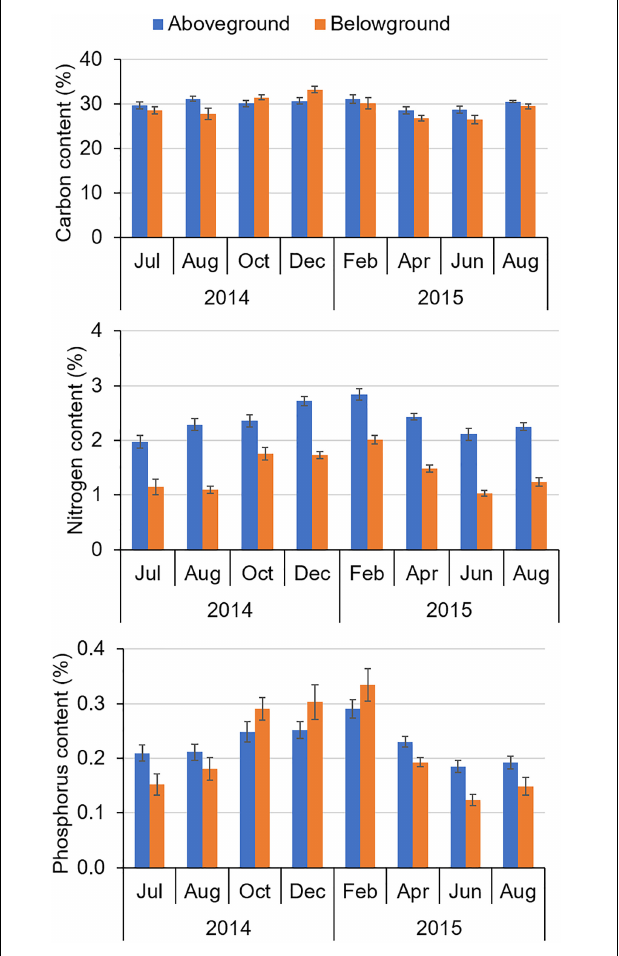
FIGURE 12 | Mean percent carbon, percent nitrogen, and percent phosphorus in seagrass tissues ± standard error (SE) from Jul 2014 to Aug 2015.